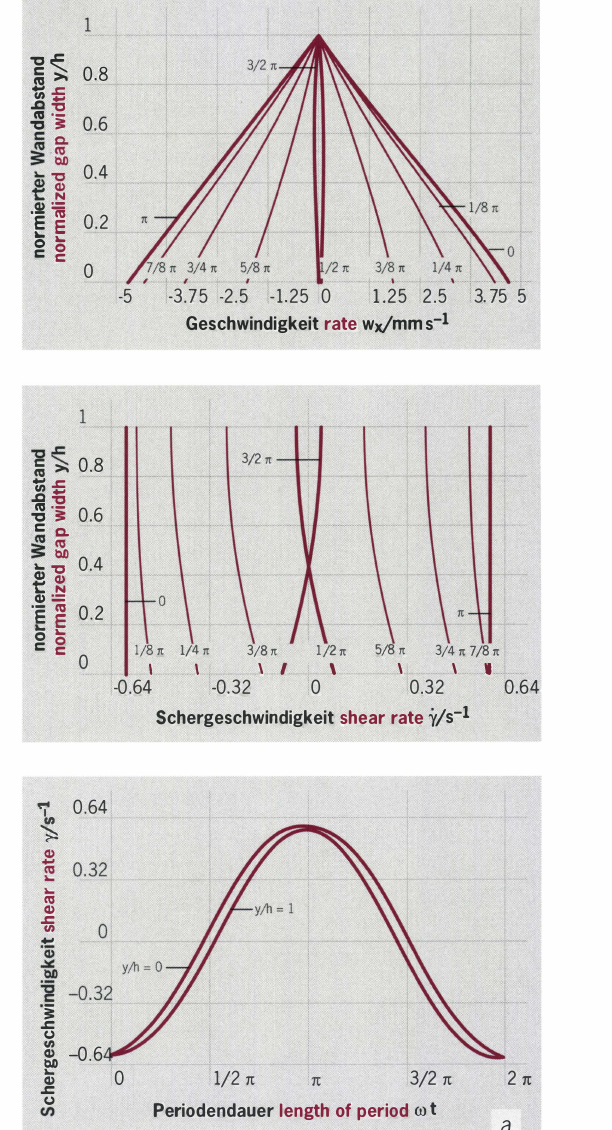
Calculation of the velocity profile according to eq. (16) is performed using a coaxial cylinder rheometer with outer radius R a = 53.45 mm and inner radius R; = 45.45 mm as a basis. Measurements were conducted on aqueous foams using this device [4]. If this coaxial geometry is considered using the two­ plate model, the plate separation would be h = 8 mm. The outer cylinder has a deflection angle 2 o. The tt = test fluid is Newtonian with a kinematic viscosity of 10-4 m2/s (glycerin). Oscillatory frequencies v = 7.94 · of 5, 20 and 80 rad/s were used. For the calculation one needs to know the maximum speed of the plate; this is obtained from the oscillation frequency w and the deflection angle of the outer cylinder. Eq. (21 ) is applicable